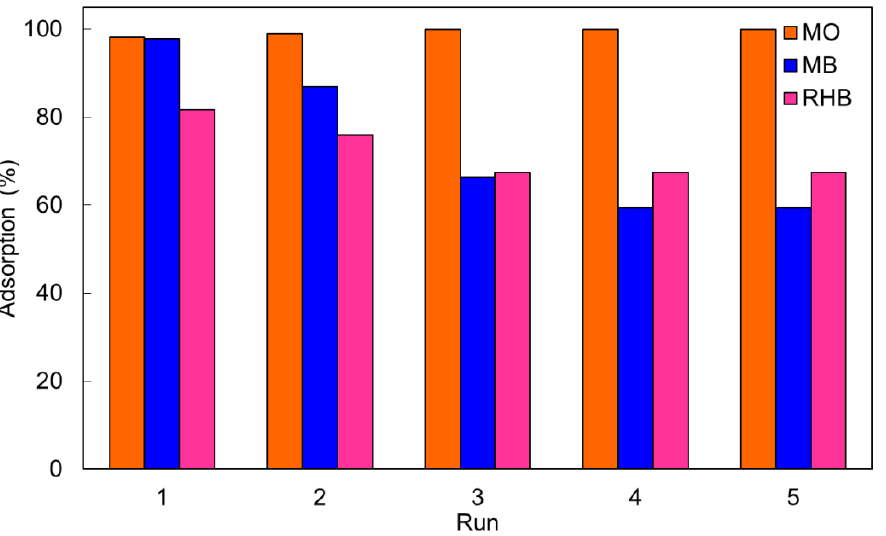
Figure 13. Adsorption by P-LS and LS under 5-run recycling.